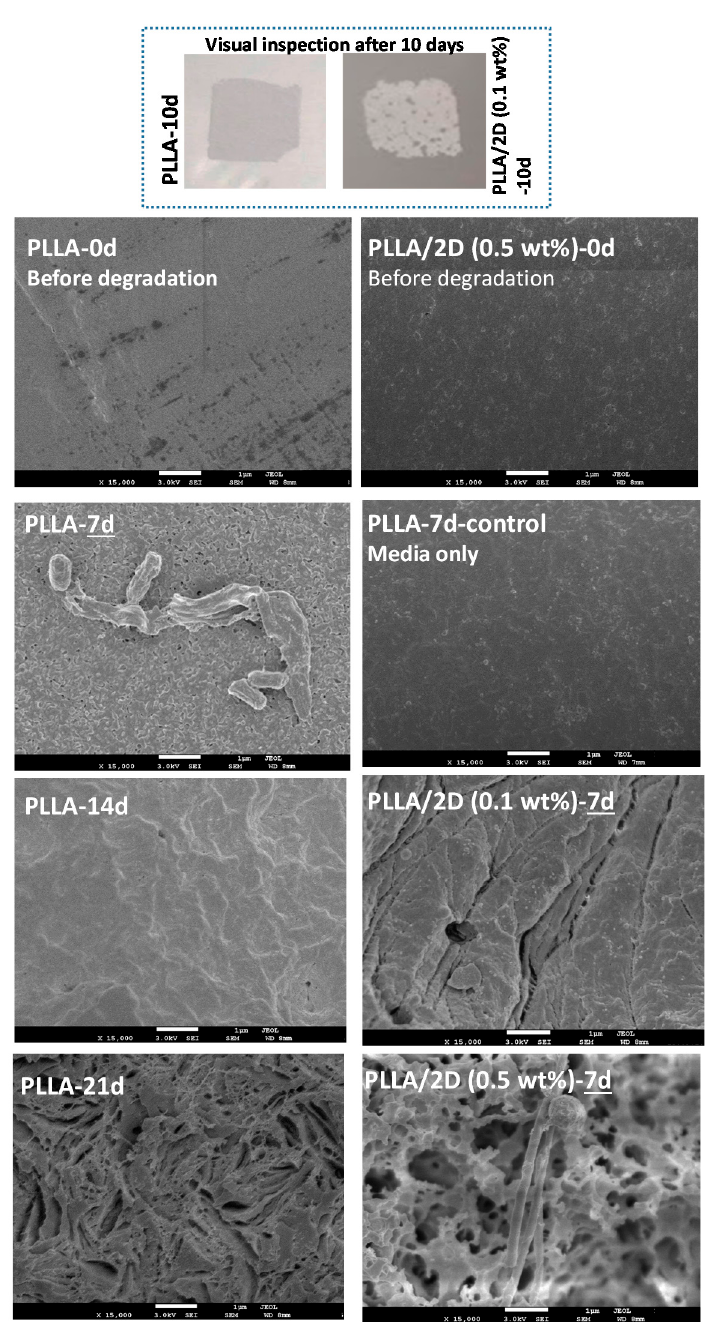
Figure 9. Optical and SEM micrographs of PLLA and PLLA / 2D-WS 2 (0.5 and 1.0 wt %) nanocomposites obtained at the incubation times indicated.